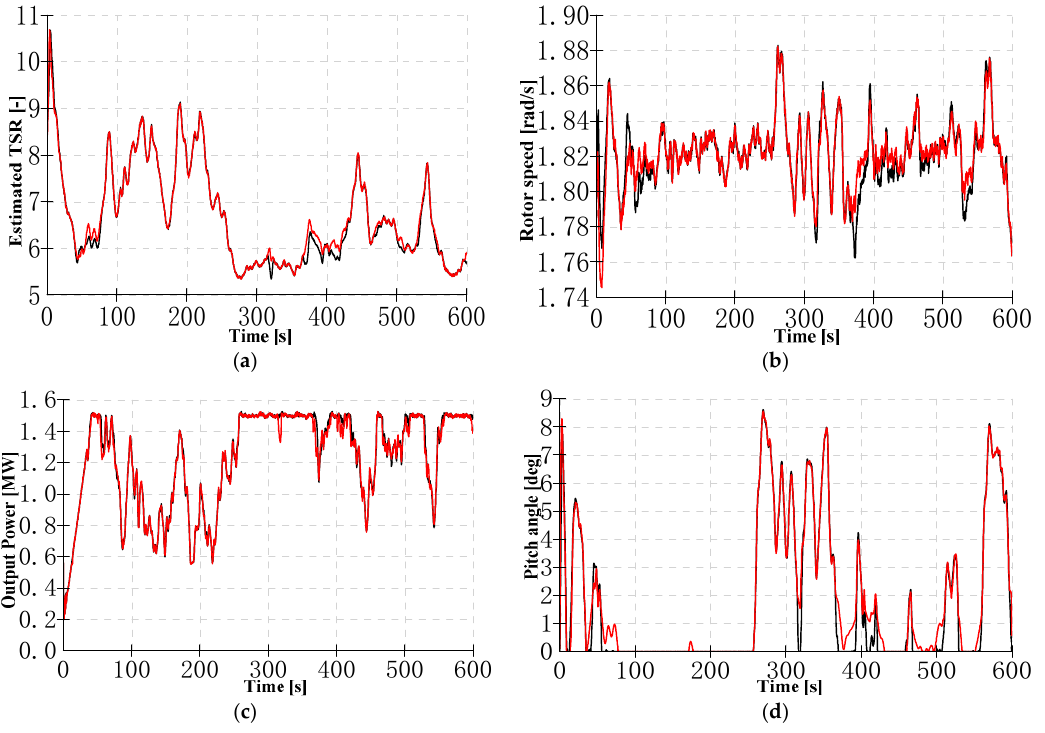
Figure 9. Simulation results under Case 5 with mean speed of 10 m/s and TI of 0.210